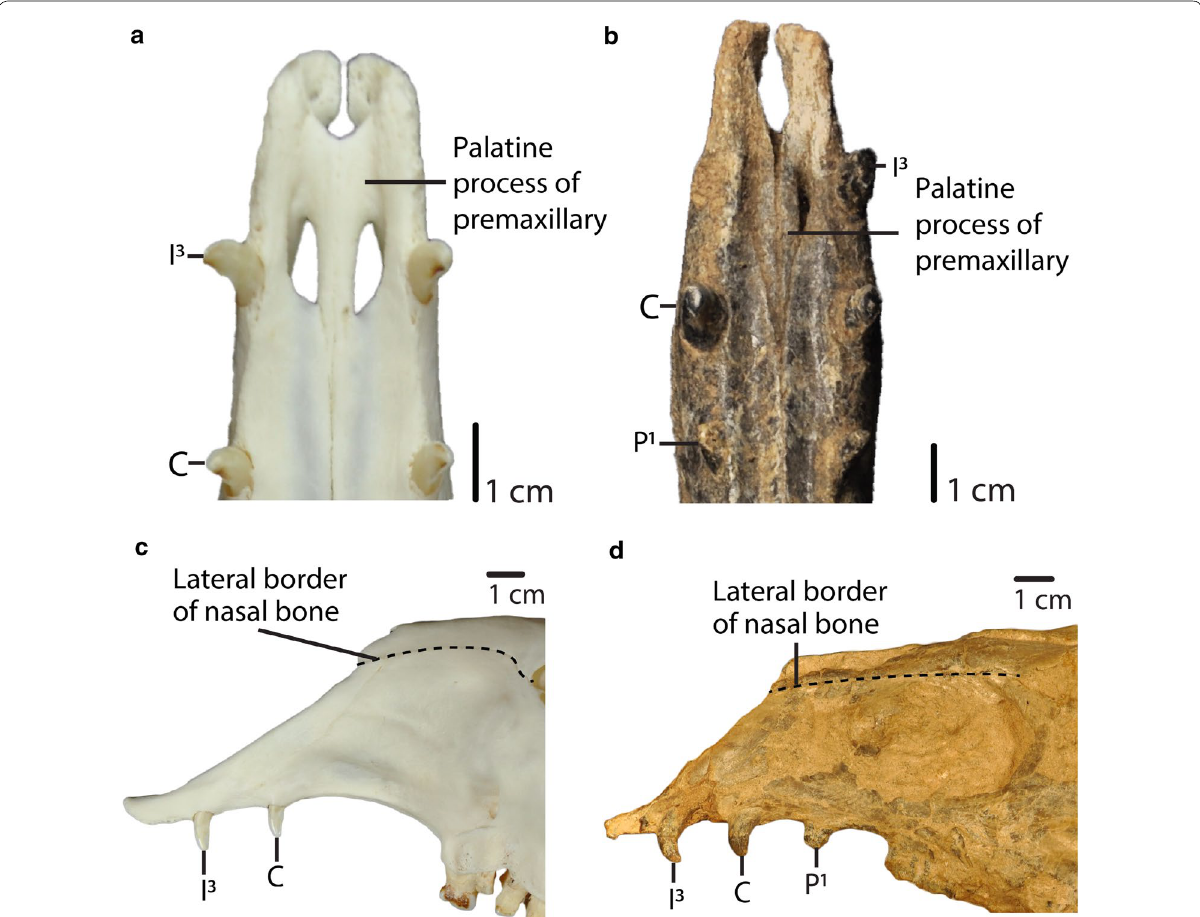
Fig. 5 a , b : Char. 20: “Position of the most posterior part of the palatine process of premaxillary”. a L. guanicoe (ZM 17,209), scored closer to the third incisor (1). b A. taylori (AMNH 40,821), scored closer to the canine (0). c , d : Char. 24: “Lateral border of nasals”. c L. guanicoe (ZM 17,209), left side, scored curved (1). d T. brachydontus (AMNH 36,594), left side, scored straight